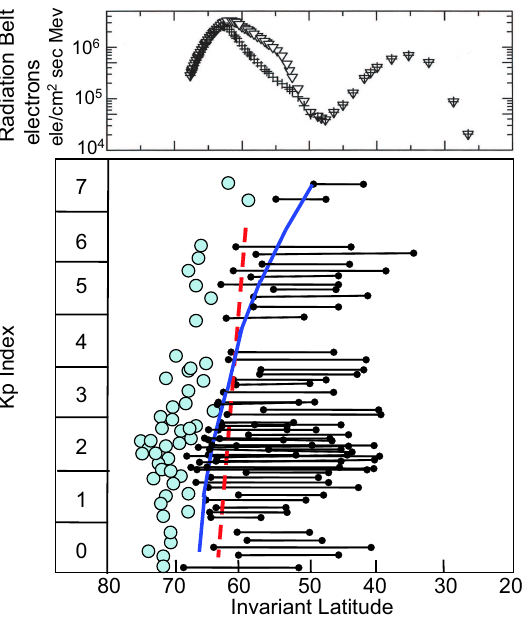
Figure 5 Morioka et al. Fig. 5. Lower panel: K p dependence of LHR band emissions with respect to invariant latitude. The horizontal solid lines indicate the latitudinal range of the emissions. The open circles show the lower latitude boundaries of the auroral hiss region. The blue line indi- Figure 3 Morioka et al. Fig. 3. Frequency spectra of LHR band emissions in the frequency cates the empirical plasmapause position. The red dotted-line indi- range from 5 to 12kHz and ELF hiss below 5kHz detected near the cates the average flux-peak position of the radiation belt electrons. plasmapause on 25 September 1985. Upper panel: Latitudinal distribution of the relativistic electrons of 1MeV (AE-8 model). The triangles show the flux distribution dur- ing the solar maximum period and the crosses during the solar min- imum